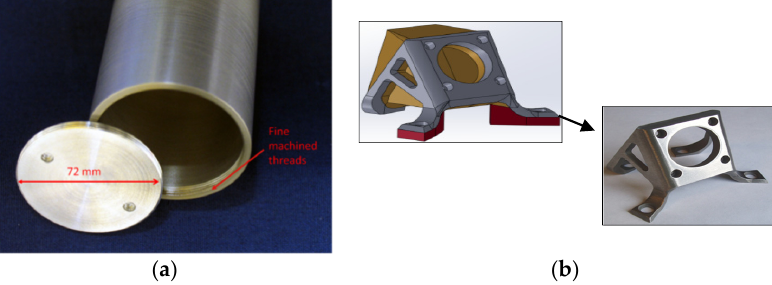
Figure 16. Micrographs of ( a ) a hollow cylinder with end cap produced by cold spray; ( b ) a bracket produced by cold spray [60].